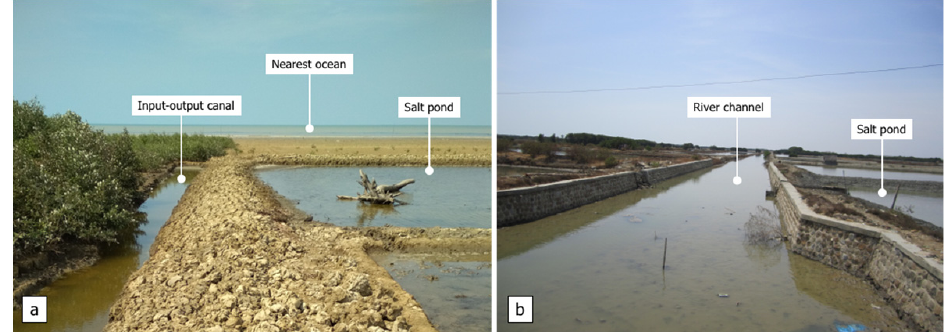
Figure 8. The example sequence of a salt production pond at very high risk based on its physical condition and location ( a ) close to the shoreline and ( b ) close to channels (pictures taken by Nirwansyah in the Pangenan district).